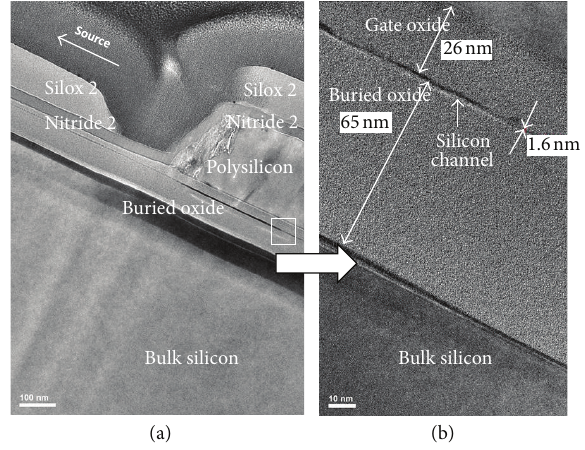
Figure 2: (a) HRTEM image of a nanoscale Body Device (NSB), showing a view of the gate’s edge away from the source contact. Since the edge of the source is located 10 𝜇 m away from the Gate’s edge, the source is not visible here. (b) Zoom in below the Gate region reveals details of the recessed Silicon Channel and confirms the 1.6 nm thickness value. Gate oxide thickness is 26